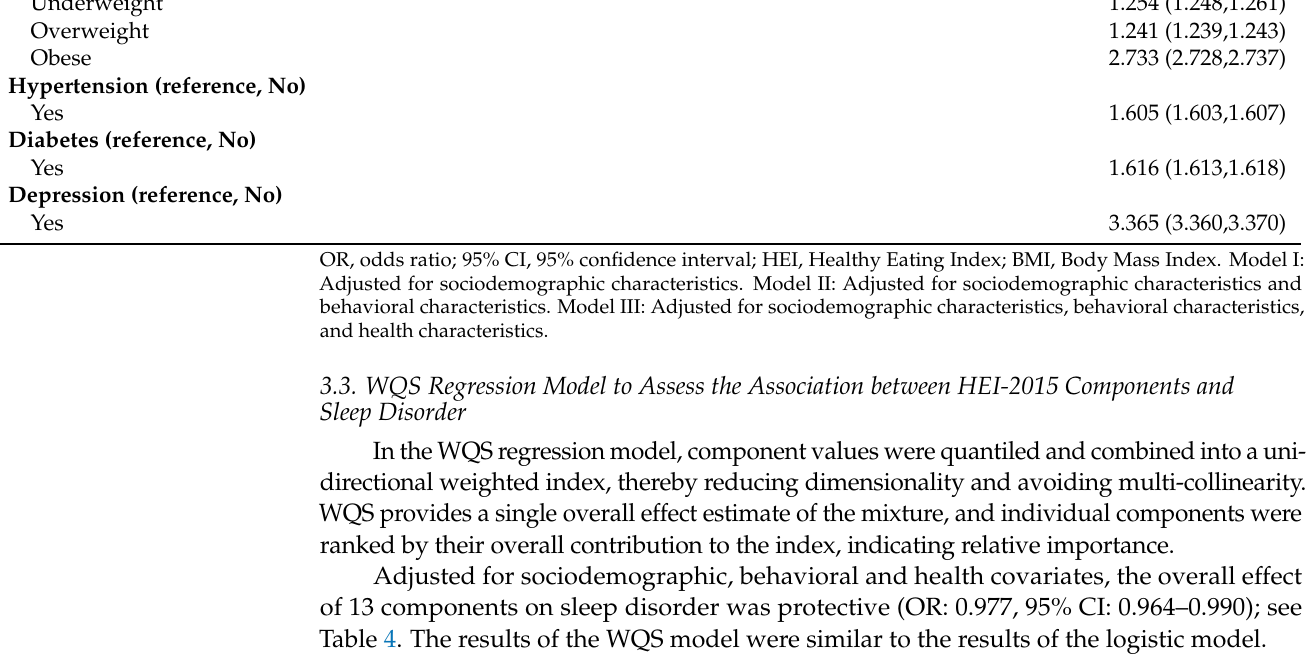
Table 4. The results of the WQS model were similar to the results of the logistic